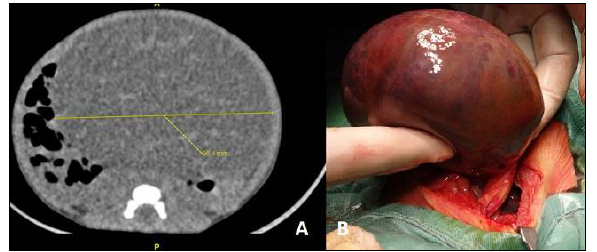
Figure 1: (A) CT scan showing huge cyst. (B) Intraoperative finding. Further investigations found her to be anemic requiring blood transfusion. Beta-hCG level was 153.8 IU/L, and alpha-feto protein level was 995328 ug/mL. The abdominal ultrasound and CT scan showed a huge, complex cystic pelvic mass measuring 10 x 7 x 10cm (Fig.1A). Laparotomy